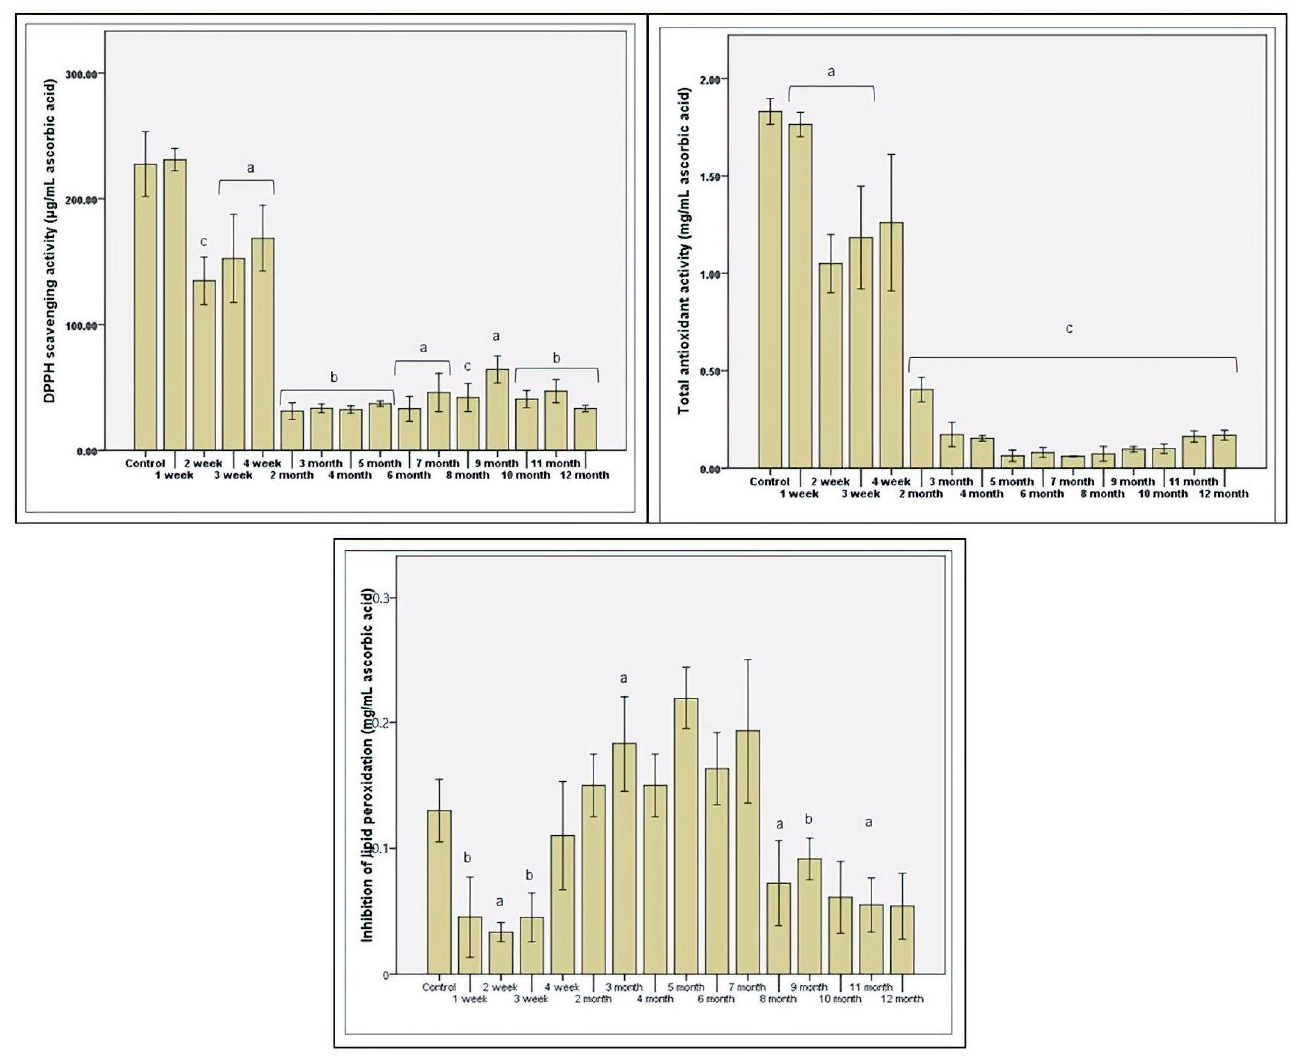
Figure 4. The antioxidant potential after in vitro long-term stevioside consumption. Different letters represent. significant statistical differences (control vs. samples; p ≤ 0.05), n = 3; fresh microbiota was used as control.